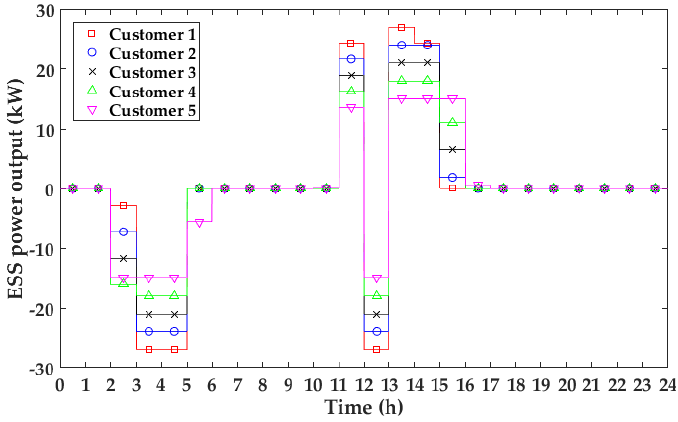
Figure 11. ESS charging schedule in Case 2 on Day 1.